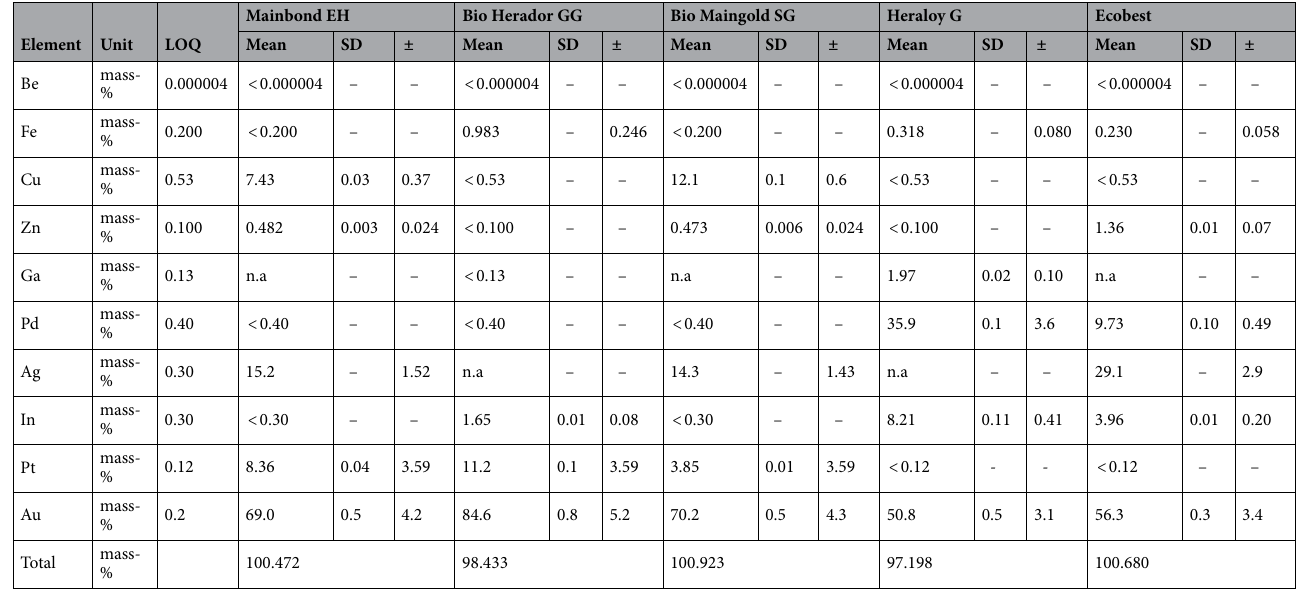
Table 5. ICP-OES results of precious metal alloys. LOQ limit of quantitation, SD standard deviation, ± : measurement uncertainty; n.a. not available.